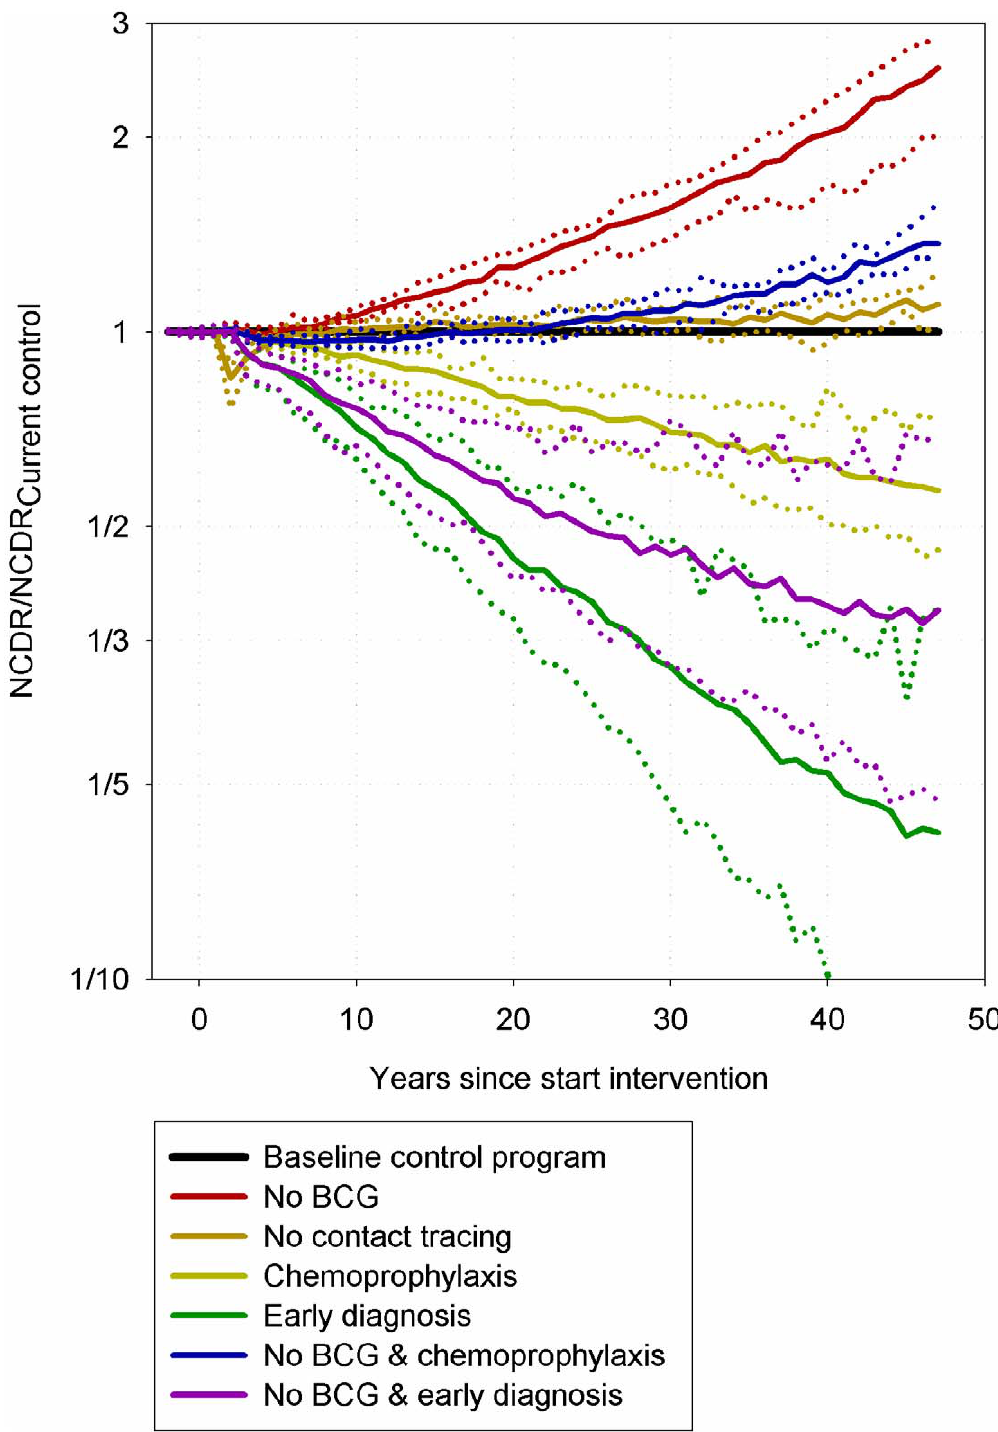
Figure 2. Predicted new case detection rates for six intervention scenarios relative to the baseline control program. For each intervention scenario simulations with different mechanisms of susceptibility to leprosy, as defined in our previous paper [9] are performed. For each intervention scenario, the two dotted lines show the smallest and largest deviations from the baseline control program. The solid line shows the median of all susceptibility mechanisms. Results are the average of 100 runs of the simulation